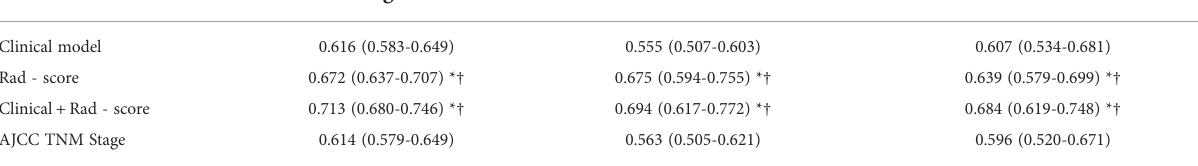
TABLE 4 Discrimination performance of the models for overall survival. Outcome: overall survival